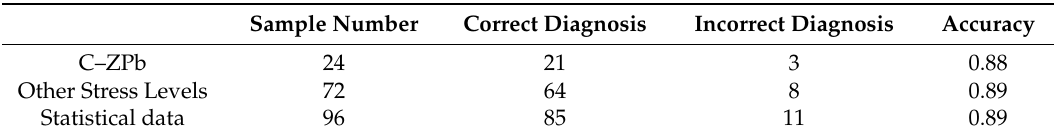
Table 3. Diagnostic details of C–ZPb with NorStaSG1D pre-processing (C-ZPb is zero Pb concentration of cross stress, and NorStaSG1D is a pre-processing method with normalization, standardization, Savitzky-Golay smoothing, and 1st-Derivative,